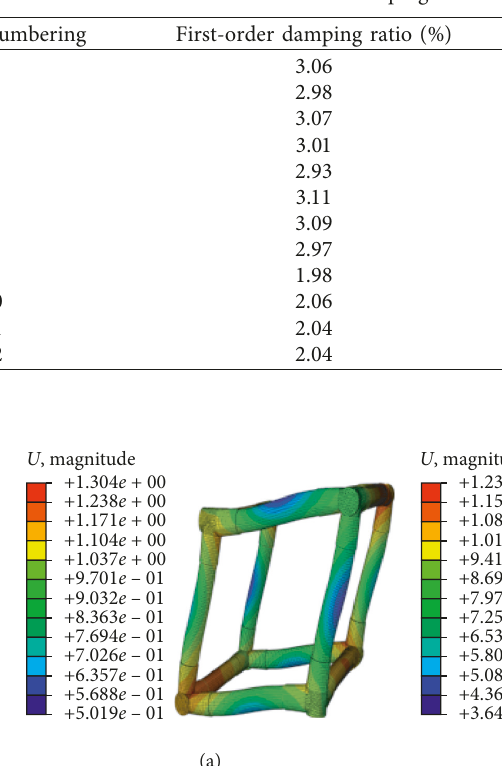
Table 1: Damping ratios of the first three orders for CFRP circular